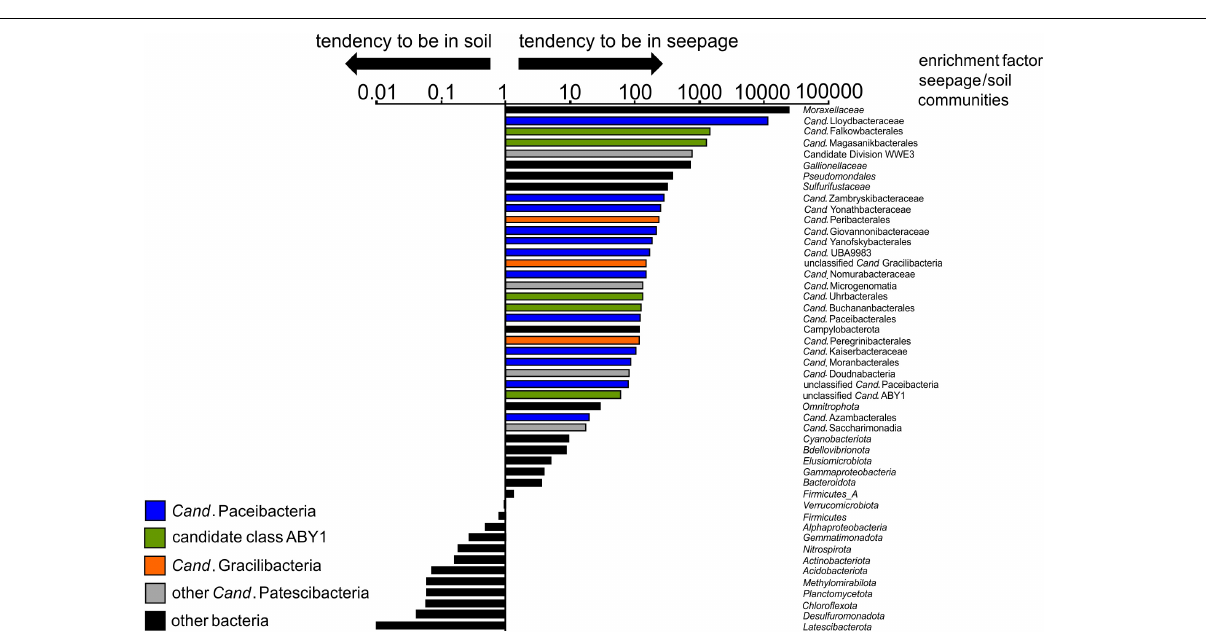
from forest soil or forest seepage to the groundwater of the lower aquifer assemblage. Their relative abundances increased from less than 0.001% in forest soil or seepage to 4.6% in the groundwater